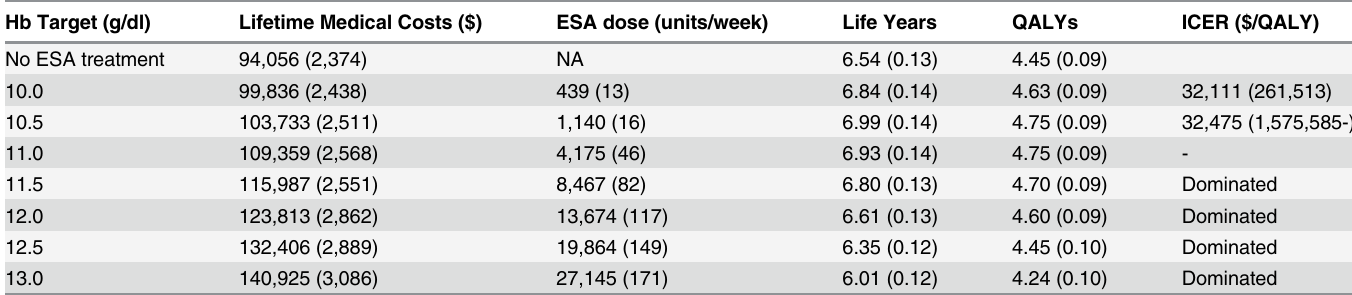
Indicated values are means. Values in parentheses are standard